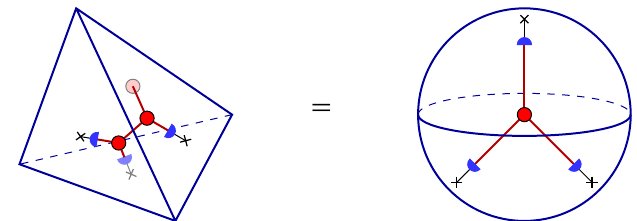
Figure 9: Triangulation of the ball S S 2 = D with three local operator insertions on 3 the boundary. It is triangulated by a single tetrahedron, with three of the boundary faces containing an insertion point. The dual triangulation is attached to those faces via a projector from A to the chiral algebra representation of the corresponding oper- ator. The network that computes the three-point function can be simplified as shown on the